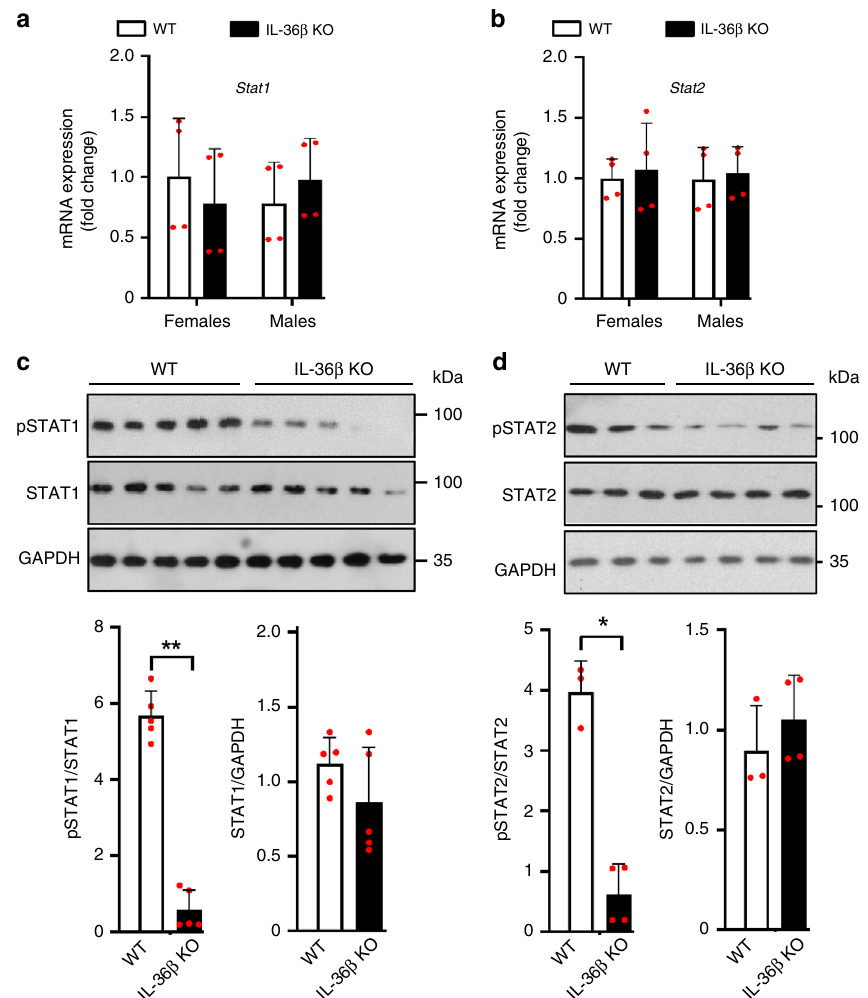
Fig. 2 IL-36 β promotes activation of STAT1 and STAT2 during HSV-1 skin infection. a , b Expression of Stat1 ( a ) and Stat2 ( b ) mRNAs were examined in wild type and IL-36 β KO HSV-1 infected skin (Fig. 1a). No statistically signi fi cant differences were detected. c Quanti fi cation of total STAT1 and pSTAT1 in wild type and IL-36 β KO HSV-1 infected skin by western blotting and ImageJ analysis (WT, n = 5; KO, n = 5). d STAT2 and pSTAT2 levels in wild type and IL- 36 β KO HSV-1 infected skin were determined by western blotting and ImageJ analysis (WT, n = 3; KO, n = 4). c , d Representative data from one of three independent experiments involving male mice is shown. Quantitative data are shown as means ± SD. * p < 0.05; ** p < 0.01 (one-way ANOVA). Each red dot represents a single data point. Source data are provided as a Source Data fi